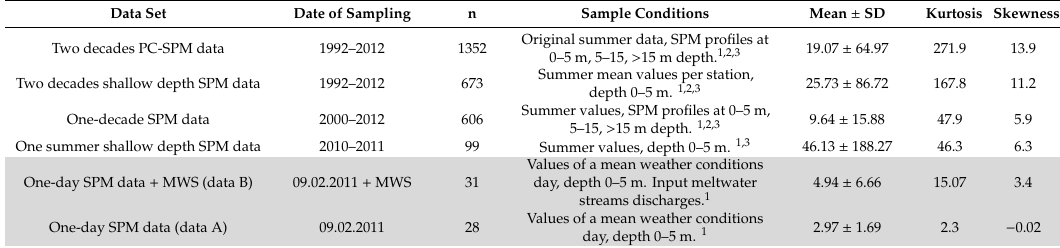
Table 1. Suspended particulate matter (SPM) data compiled and published by several authors [26,27,54–57] among 20 years of research in Potter Cove (PC), Antarctic (joint in Neder et al. [58]). Data increasing time resolution reduced by semivariogram cloud and normality analysis to apply the geostatistical model with two approaches (in grey): with meltwater streams discharges with SPM inputs -MWS- and without.